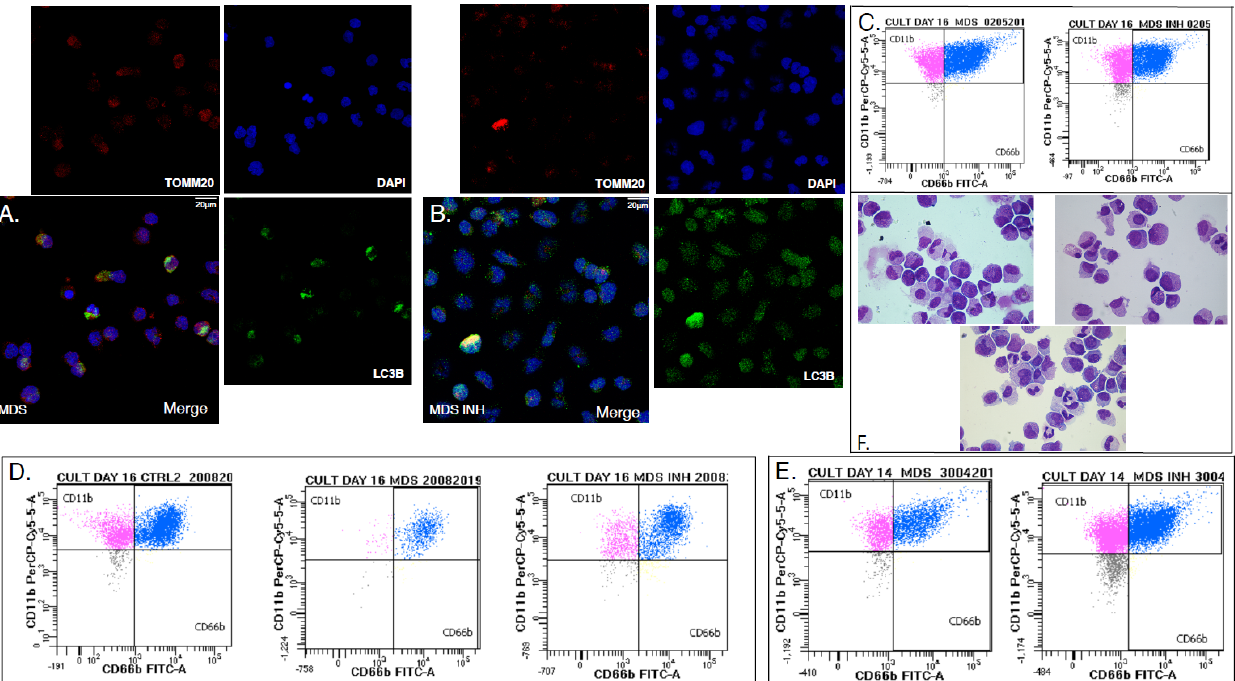
Figure 5. Effects of HIF-1 α inhibition on human CD34+ in vitro cultures primed toward myeloid differentiation. ( A , B ) Assessment of differentiation, mitochondrial content, and autophagy through immunofluorescence for DAPI (blue), TOMM20 (red), and LC3b (green), objective 63×/1.4NA. ( A ) MDS, ( B ) MDS plus HIF-1 α inhibitor culture day 16. ( C ) Flow cytometry for differentiation markers CD66b/CD11b and photon microscopy of culture cytospin showing differentiation improvement in one out of three presented cultures. ( D , E ) Flow cytometry for differentiation markers CD66b/CD11b of two independent experiments on days 16 ( D ) and 14 ( E ) show marked quantitative and qualitative improvement. ( F ) Photon microscopy of May-Gruenwald/Giemsa stained cytospin from the ( D ) culture on day 16 showing numerical ex- pansion and differentiation improvement. Objective (×100). Upper left: Control, Upper right: MDS, Lower center: MDS+INH. All experiments were performed in CD34+ HSCs from patients suffering from MDS with <5% intra bone mar- row blasts. One representative control is shown. Each MDS culture corresponds with one or more control cultures. LC3B: Microtubule-associated proteins 1A/1B light chain 3B, MPO: Myeloperoxidase, TOMM20: Translocase of Outer Mitochon- drial Membrane.